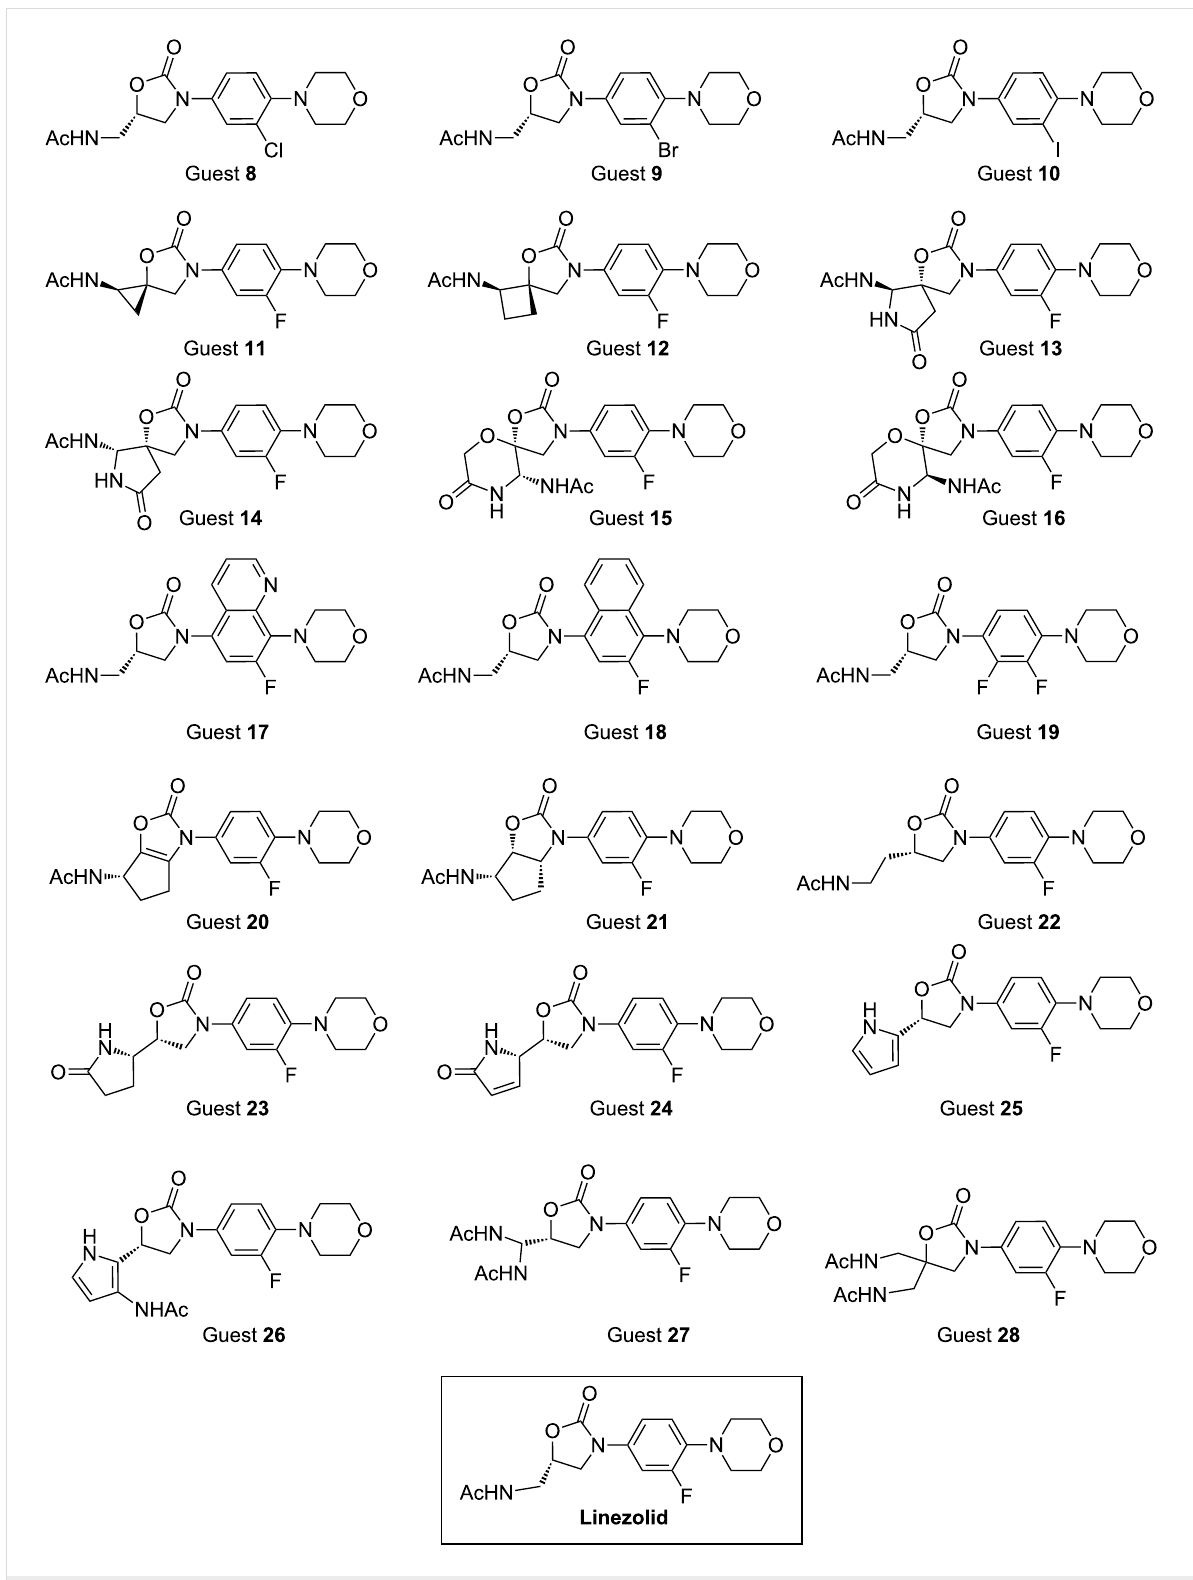
Scheme 1: Scheme 2 in the original article: Predicted new linezolid-like